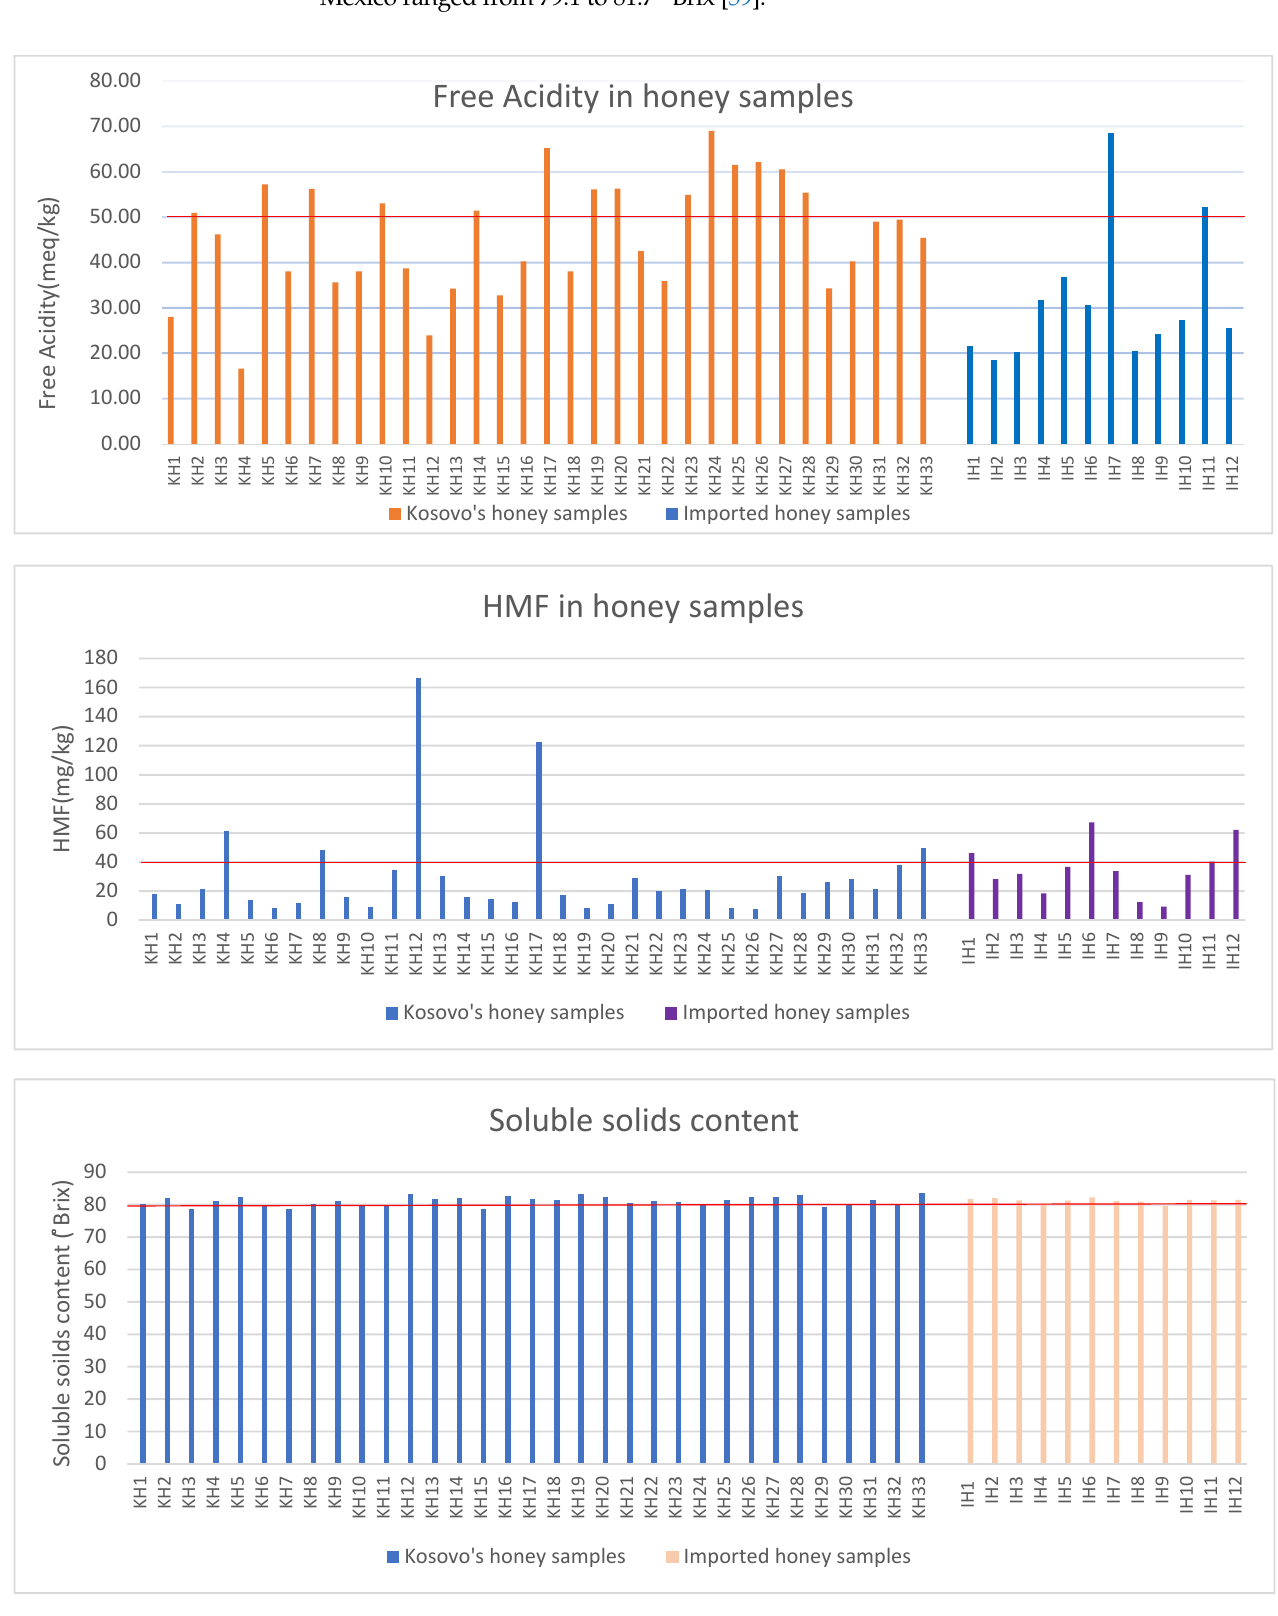
from Portugal ranged from 79.0 to 82.2 ◦ Brix, while the content of soluble solids of honey from Mexico ranged from 79.1 to 81.7 ◦ Brix [59].